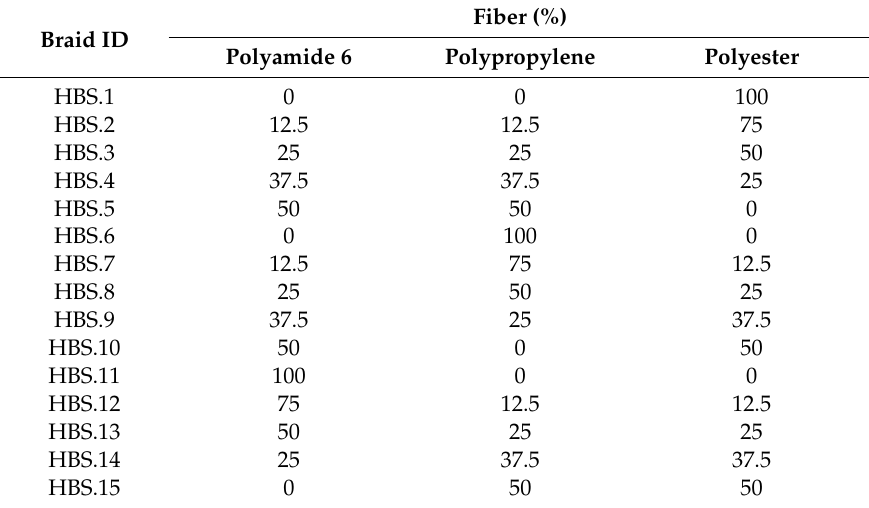
Table 2. Specifications of manufactured